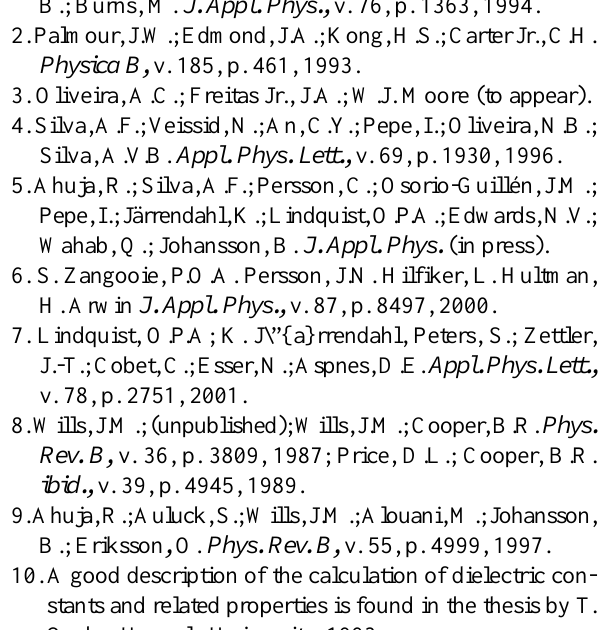
and imaginary part e 1